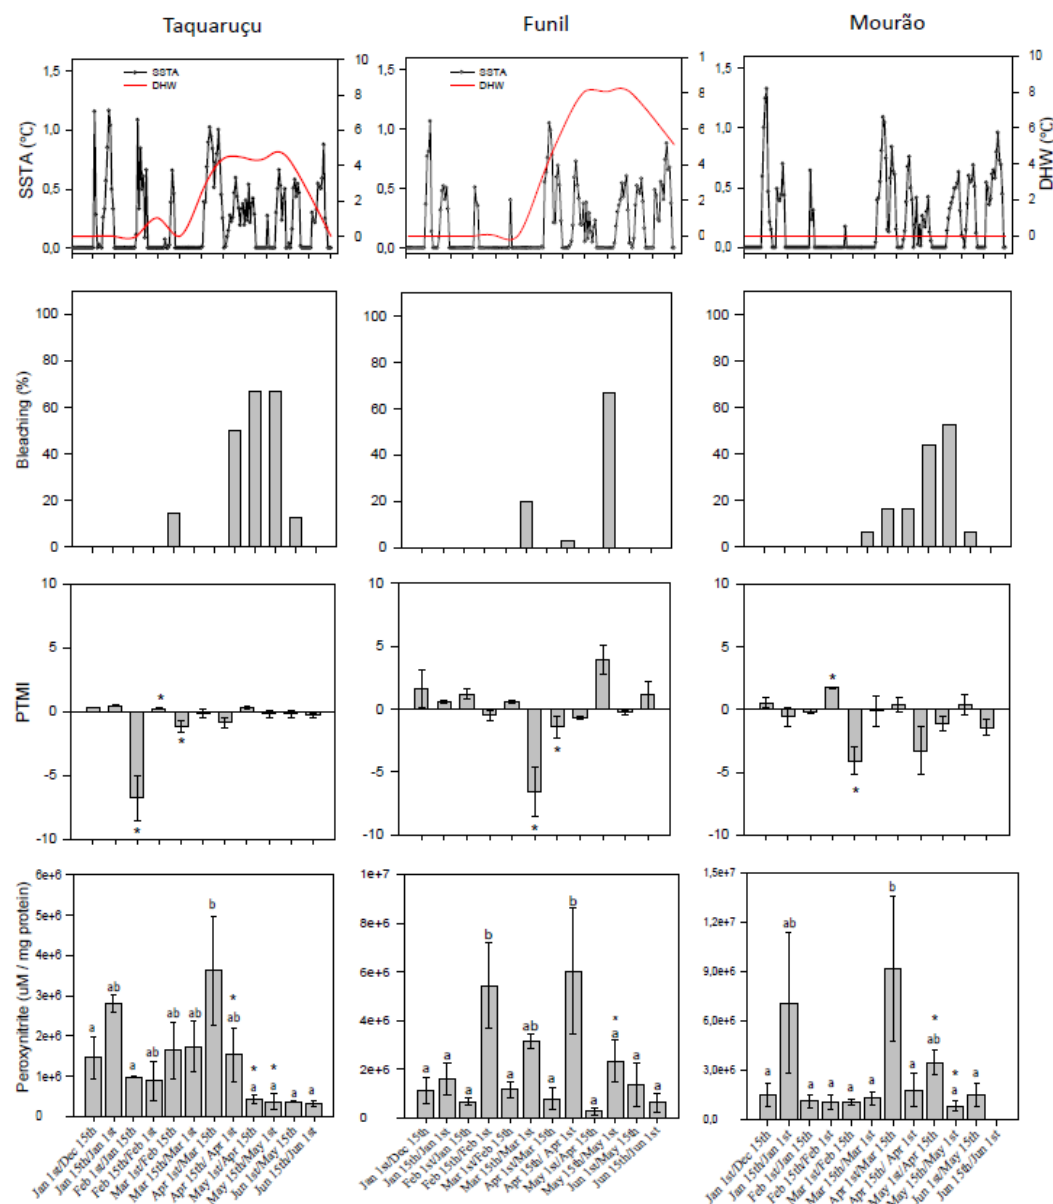
Figure 3. Thermal stress parameters [degree heating weeks (DHW) and daily sea surface temperature anomaly (SSTA)], bleaching frequency (%), Predominant Trophic Mode Index (PTMI), and peroxynitrite levels (µM/mg protein) for Mussismilia harttii at the three sites (Taquaruçu, Funil, and Mourão) of the Recife de Fora Marine Protected Area (Southwestern Atlantic), from January 2015 to June 2016, during El Niño Southern Oscillation. For PTMI data, positive and negative values indicate prevalence of autotrophy and heterotrophy, respectively, with asterisks (*) indicating significant shifts of feeding mode prevalence over time ( p ≤ 0.05). For peroxynitrite data, different letters indicate significant differences over time ( p ≤ 0.05) and asterisks (*) indicate more than 40% bleaching frequency observed. Data on PTMI and peroxynitrite are means ± s.e.m of three to four samples.